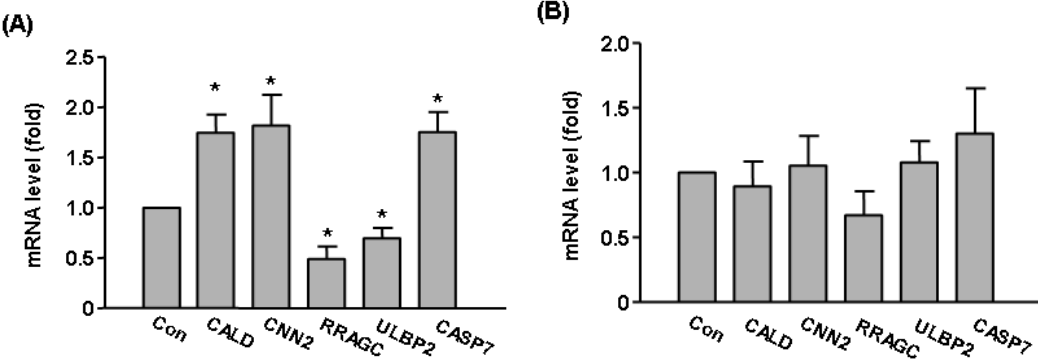
Figure 5. Validation of microarray results with qPCR. The expression levels of CALD1 , CASP7 , CNN2 , RRAGC , ULBP2 were measured in ( A ) Sirt2i cells and ( B ) Sirt1i cells in the presence of oxidant stress (H O 300 μ M for 6 h). Gene expression levels were expressed 2 2 as fold of control. Data are mean  SEM. * p < 0.05 vs. Con, Student’s t -test, n = 3–4.